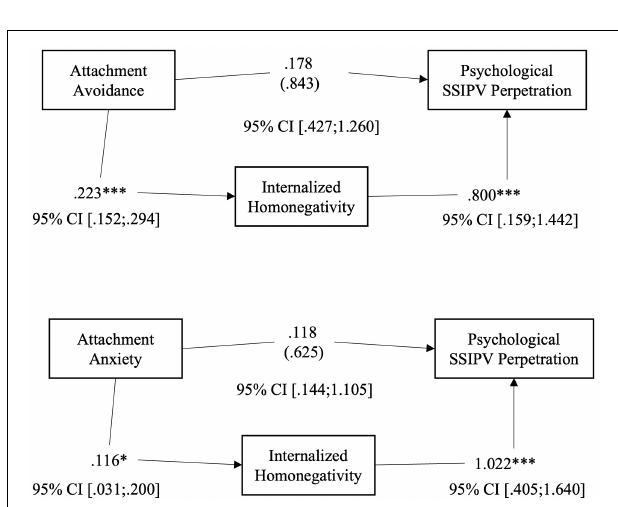
FIGURE 4 | Hp. 3 Path analysis with the score of perpetrated Physical Aggression as the outcome; the total score of MISS as the mediator, and the score of anxiety and avoidance as the predictors. * p < 0.05; *** p < 0.001. ns: not significant.